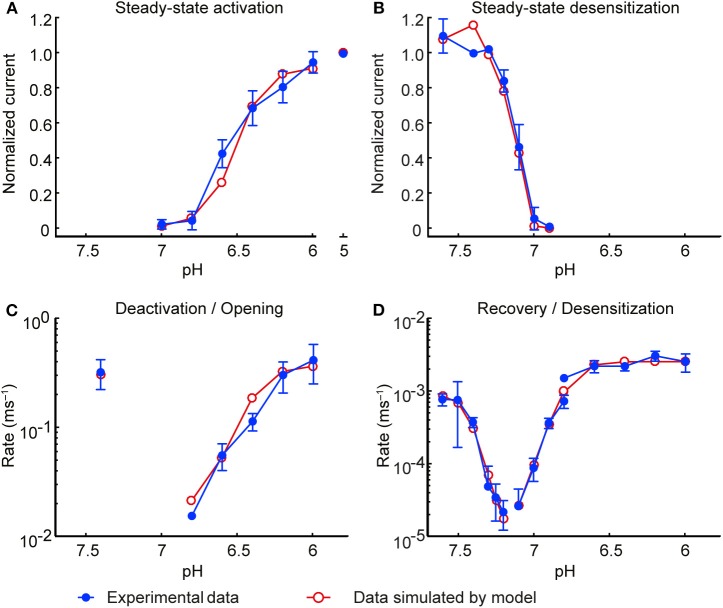
Model of the ASIC1a current: simulations vs. experiments. Experimental data are shown in blue and model results in red. Currents were measured from CHO cells stably expressing ASIC1a, in the whole-cell mode (A,B; D except for desensitization from the open state) or from excised outside-out patches (C; D, desensitization from the open state). (A) Steady-state activation. (B) Steady-state desensitization (SSD). Experimental data in A and B are the same as in Figures 2A,C; the corresponding protocols are described in the legend of Figure 2. (C) Rate of opening and deactivation. (D) Rate of desensitization and recovery from desensitization. Experimental data in (C,D) are the same as in Figure 1F. In all simulations, the model was subjected to the same pH protocols and its output to the same analyses in the experiments.